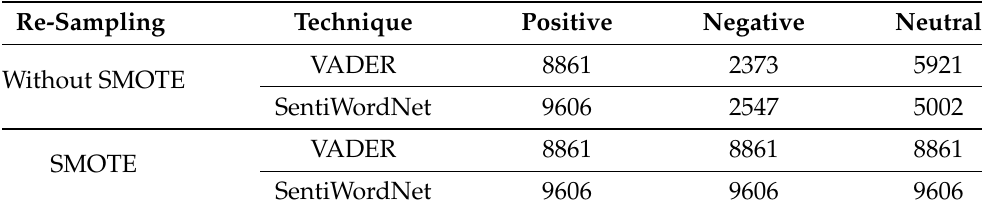
Table 17. Vader and SWN train and test count after data